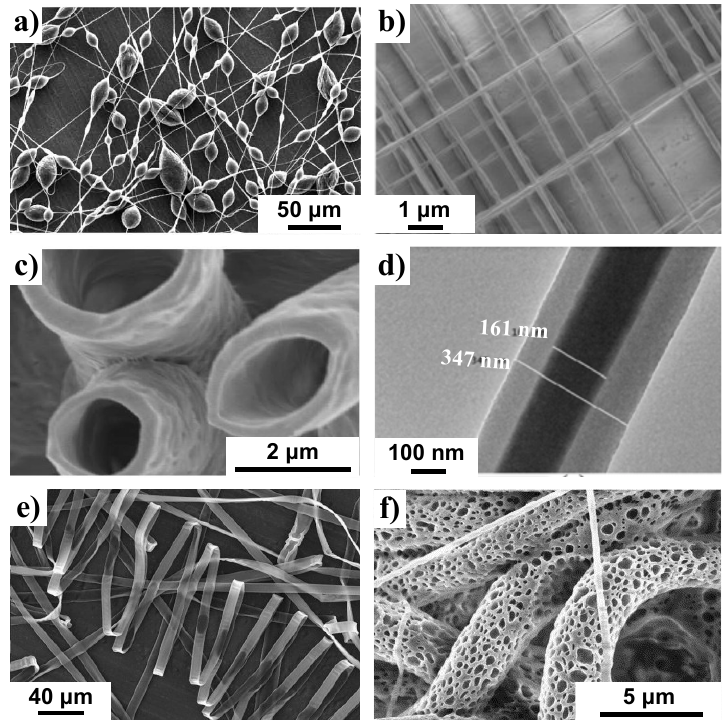
Figure 1. Different fiber morphologies achieved by various researchers using the electrospinning Figure 1. Differentfibermorphologiesachievedbyvariousresearchersusingtheelectrospinningtechnique: technique: ( a ) beaded [13]; ( b ) aligned [14]; ( c ) hollow [15]; ( d ) core-sheath [16]; ( e ) flat ribbon [17]; ( f ) ( a ) beaded; ( b ) aligned; ( c ) hollow; ( d ) core-sheath; ( e ) flat ribbon; ( f ) porous. Reproduced with